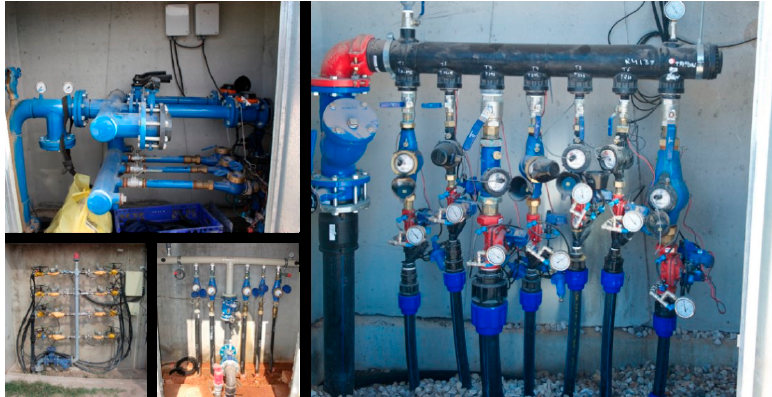
Figure 2. Variable configurations of multioutlet hydrants in the field.